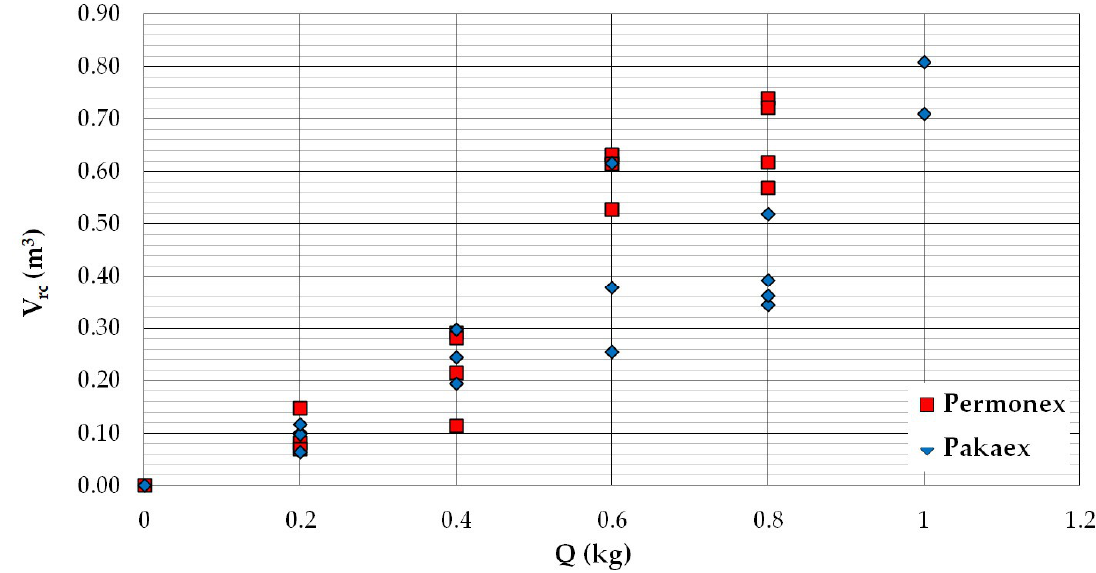
Figure 10. The dependence of the resulting volume of expansion V rc (m 3 ) on the mass of explosive charge Q (kg), for Permonex V19 and Pakaex.